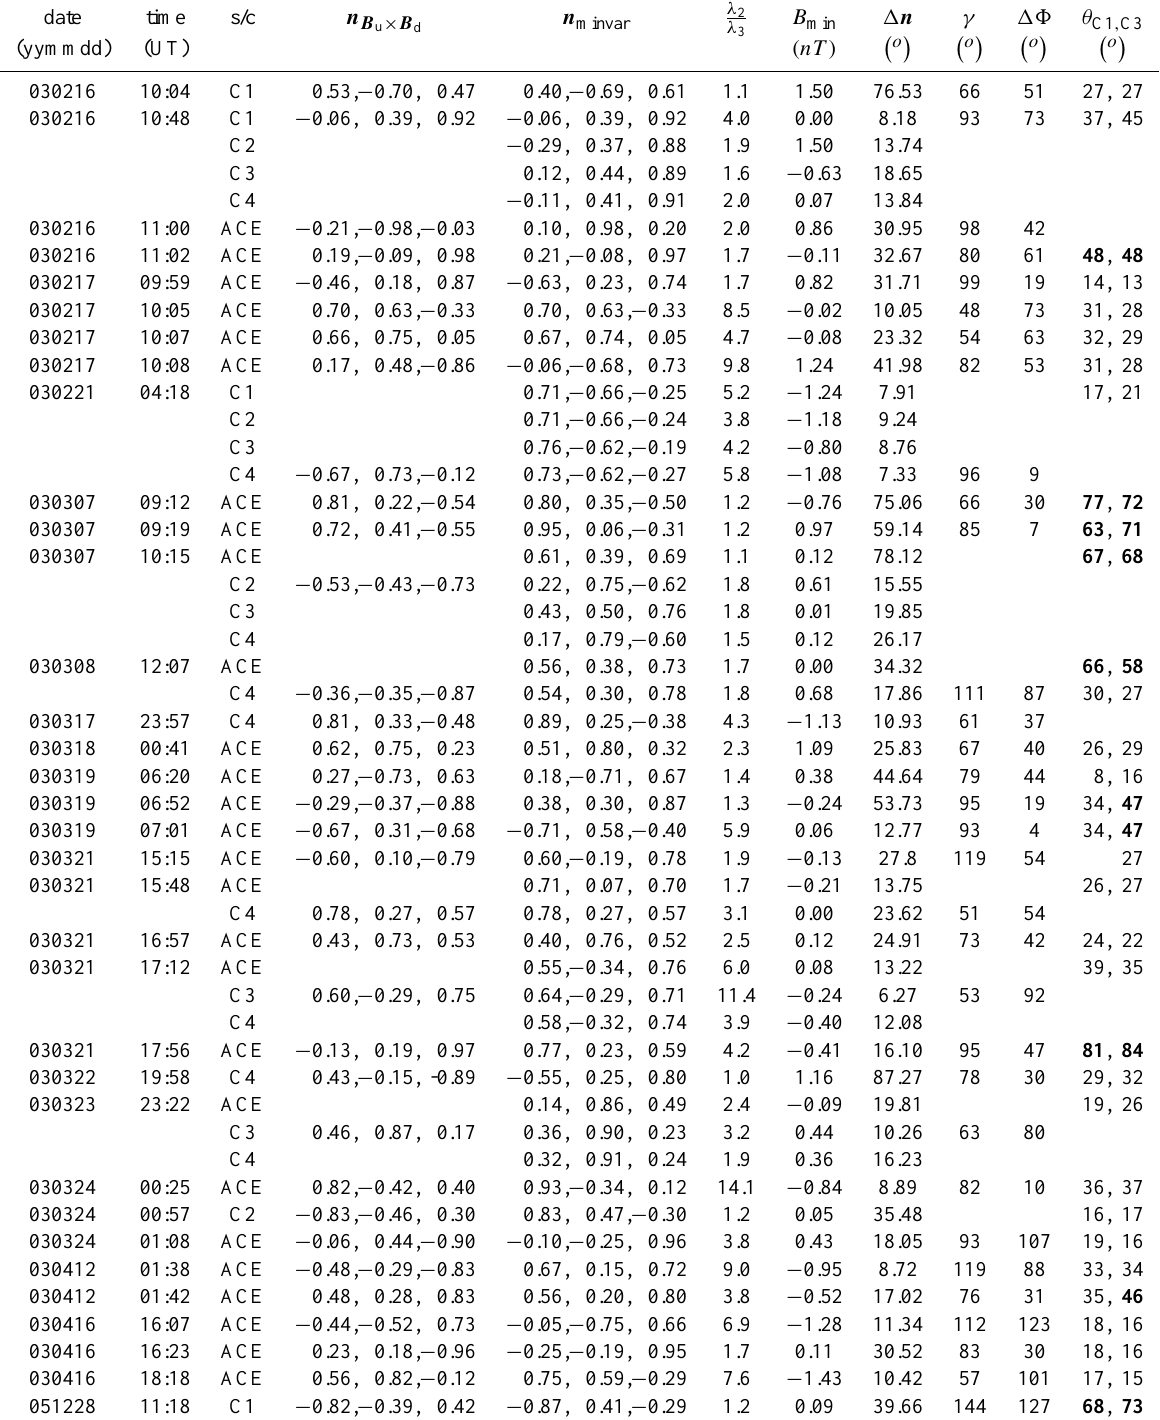
Table 2. Parameters of TD normal vectors: λ 2 /λ 3 is the ratio of 2nd and 3rd eigenvalues, B min is the smallest magnetic field component in minimum variance system, 1 n is the error cone of minimum variance method, γ is the angle between the Sun direction and TD normal, 18 is the direction change across the discontinuity and θ the angle between the bow shock normal and the B magnetic field vector. Boldface letter shows quasi-perpendicular conditions; the angles were calculated by scaling a model BS to the location of Cluster-1 and 3